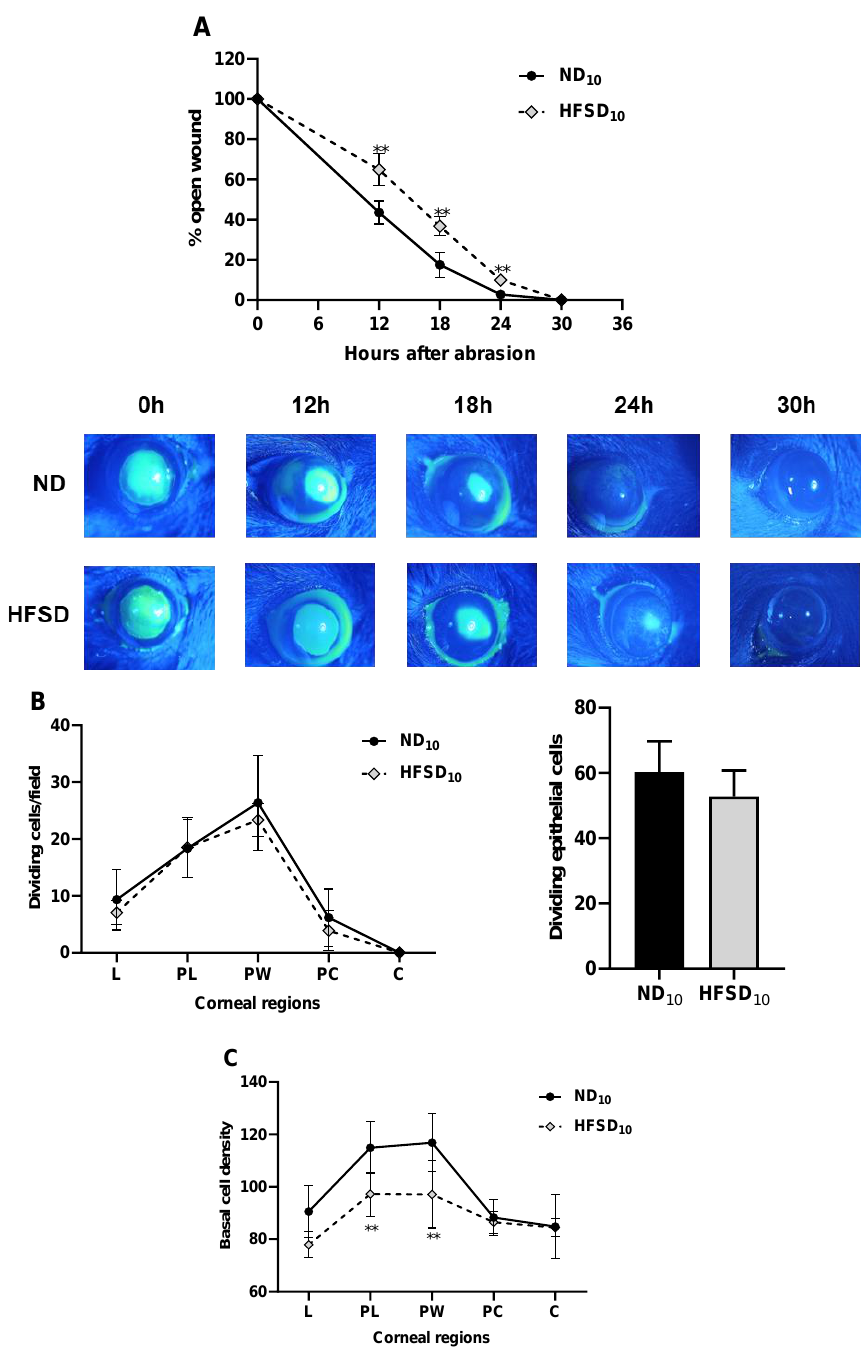
Figure 3. High-fat/sucrose diet feeding for 10 weeks impairs corneal wound healing. ( A ) Corneal wound closure in mice fed a normal or high-fat/sucrose diet. Top: Wound closure kinetics. Bottom: Representative images of the epithelial wound immediately after wounding, 12 h, 18 h, 24 h, and 30 h after wounding. ( B ) Left: Dividing basal epithelial cells in each region of the cornea. Right: Sum of dividing basal epithelial cells in four fields of view from the periphery to the center of the cornea & ( C ) Basal epithelial cell density in each region of the cornea at 30 h after wounding. Data expressed as mean ± S.D. ND 10 —10-week normal diet; HFSD 10 —10-week high-fat/sucrose diet; L—limbus; PL—paralimbus/periphery; PW—parawound; PC—paracentral; C—center; ** p ≤ 0.01 Regulated neutrophil extravasation and subsequent migration to the wound center are crucial for efficient corneal wound healing. At 30 h post-wounding, the number of extravasated neutrophils at the corneal limbus was not different between high-fat/sucrose